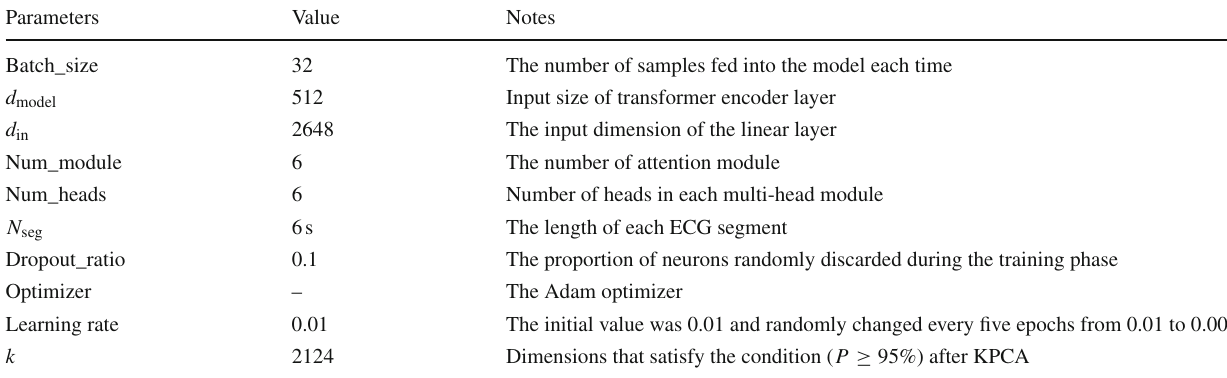
Table 3 The main parameter settings of each model in the Python development